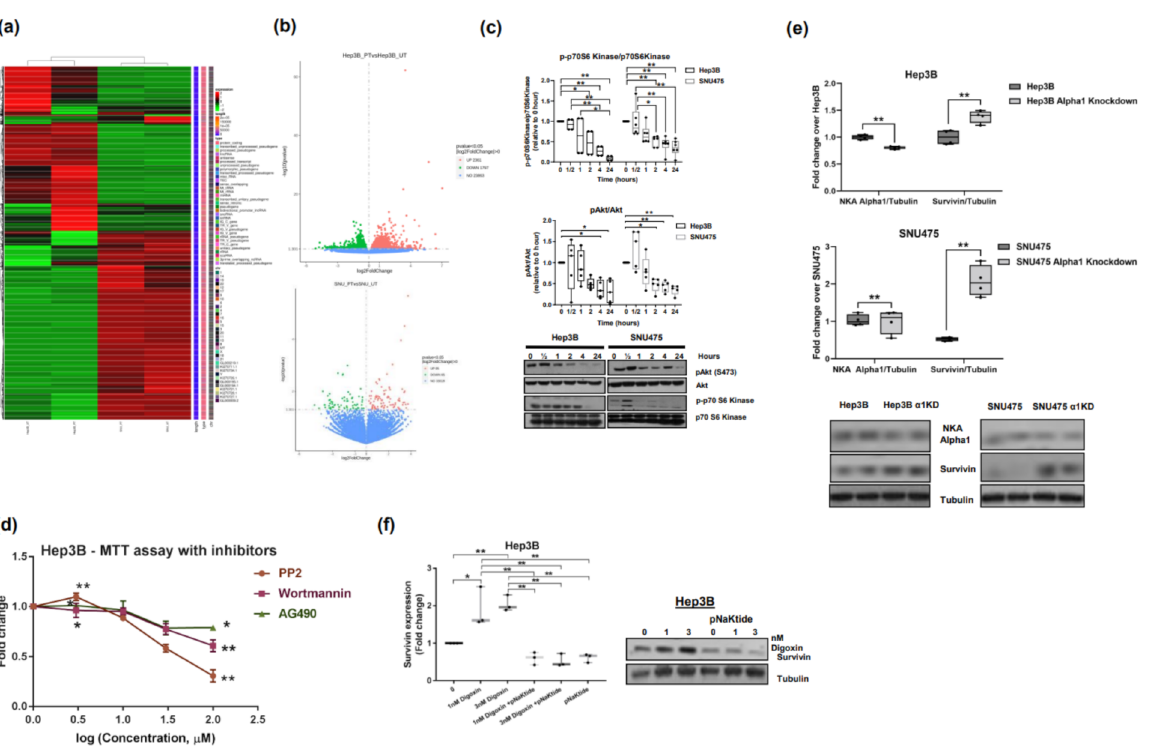
The α 1-NKA-KND cell line significantly overexpressed survivin (Figure 6e). Additionally, digoxin, a specific ligand of NKA, was used to test the effect of α 1-NKA signalosome activation on survivin expression. Digoxin significantly upregulated survivin expression in a dose-dependent manner, an effect that was rescinded in cells treated with pNaKtide (Figure 6f). Digoxin mediates its action by binding to the α -subunit of NKA and is the only FDA-approved cardiac glycoside indicated for the treatment of patients with mild or mod- erate heart failure and reduced ejection fraction [41,42]. Additionally, the administration of pNaKtide enhanced FoxO3 apoptotic signaling in the two pNaKtide-treated HCC cell lines by significantly increasing the nuclear expression of FoxO3 (Figures 7 and S6c,d). The forkhead box O (FoxO) family of transcription factors is recognized as a tumor suppressor that plays key roles in cell cycle arrest, senescence, apoptosis, differentiation, DNA damage repair, and scavenging of reactive oxygen intermediates (ROI) [43,44].